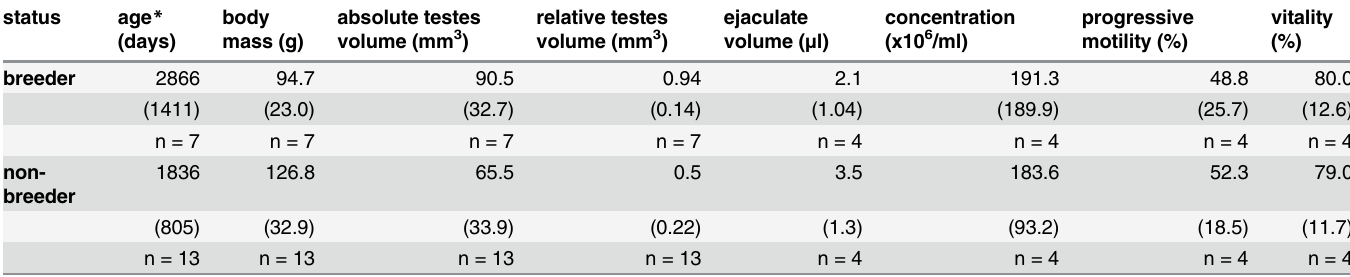
Table 1. Main parameters (mean, SD given in parenthesis) of male reproductive characteristics measured in Ansell ’ s mole-rats. Volumes estimated for the right and left testis of each male were averaged to obtain mean absolute and relative testes volumes, respectively. * The minimum age at the time of testis measurement was estimated for two specimens since they were caught in the field in Lusaka,